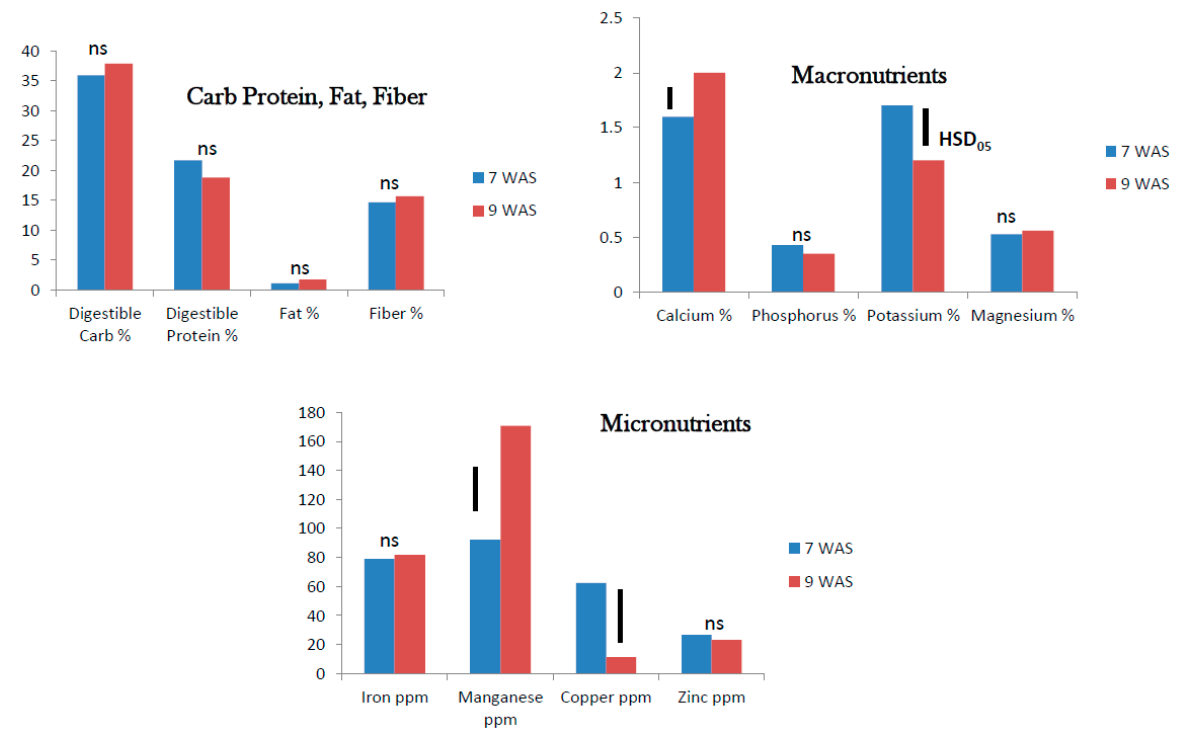
Figure 5. Field grown roselle: Nutrient status 7 and 9 weeks after sowing (WAS) (ns = no significant difference, bars show Tukey’s HSD at α = 0.05).